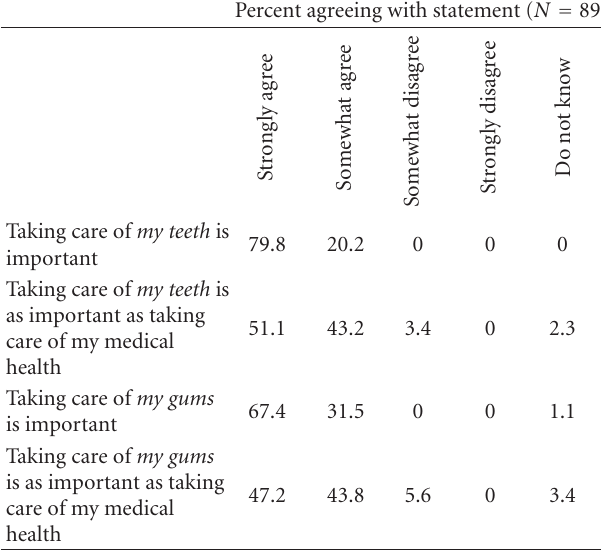
Table 5: Importance of oral health for adolescents with type 1